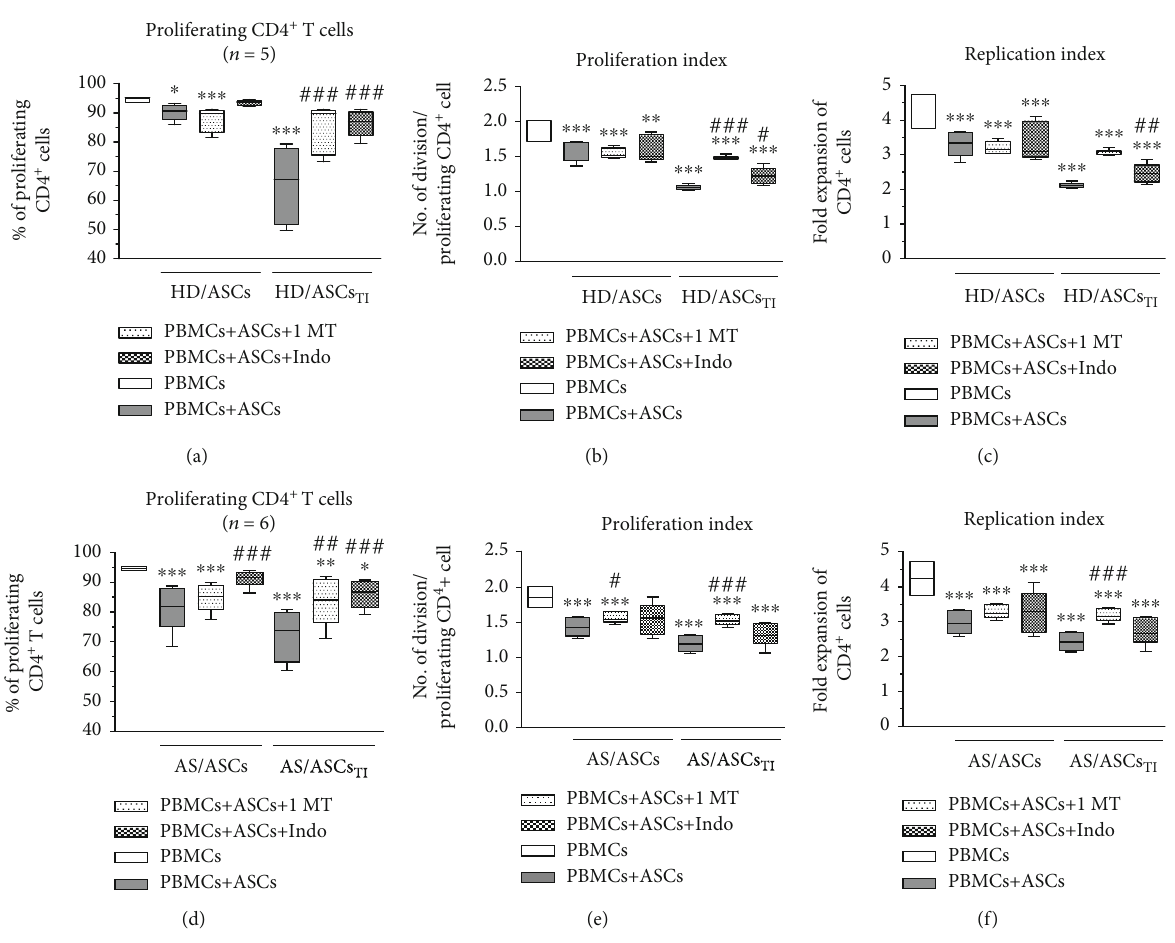
Figure 6: Selective inhibitors of kynurenines (1-MT) and PGE (indomethacin) synthesis counteract inhibitory e ff ect of ASCs on 2 proliferation of CD4 + T cells. Cell preparation and culture conditions as in Figure 1. The concentrations and time of cell treatment with 1-MT and indomethacin (Indo) are described in Materials and Methods. Data are shown as the Tukey ’ s boxes; the number of performed experiments ( n ) is shown. ∗ P = 0 : 05 ‐ 0 : 01 , ∗∗ P = 0 : 01 ‐ 0 : 001 , and ∗∗∗ P = 0 : 001 ‐ 0 : 0001 for comparison of cell cocultures vs. control separate cultures. # P = 0 : 05 ‐ 0 : 01 , ## P = 0 : 01 ‐ 0 : 001 , and ### P = 0 : 001 ‐ 0 : 0001 for comparison of inhibitor treated vs. untreated cocultures. Other explanations as in Figure